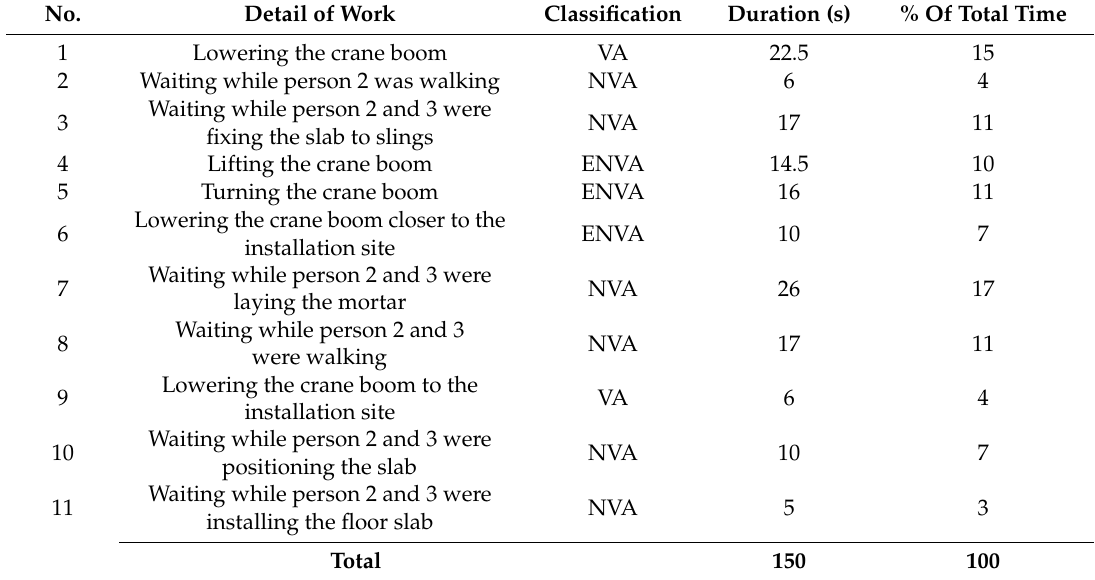
Table 1. Average data gathered from the VSM of the process “installation of a floor slab” for person 1 (crane operator).